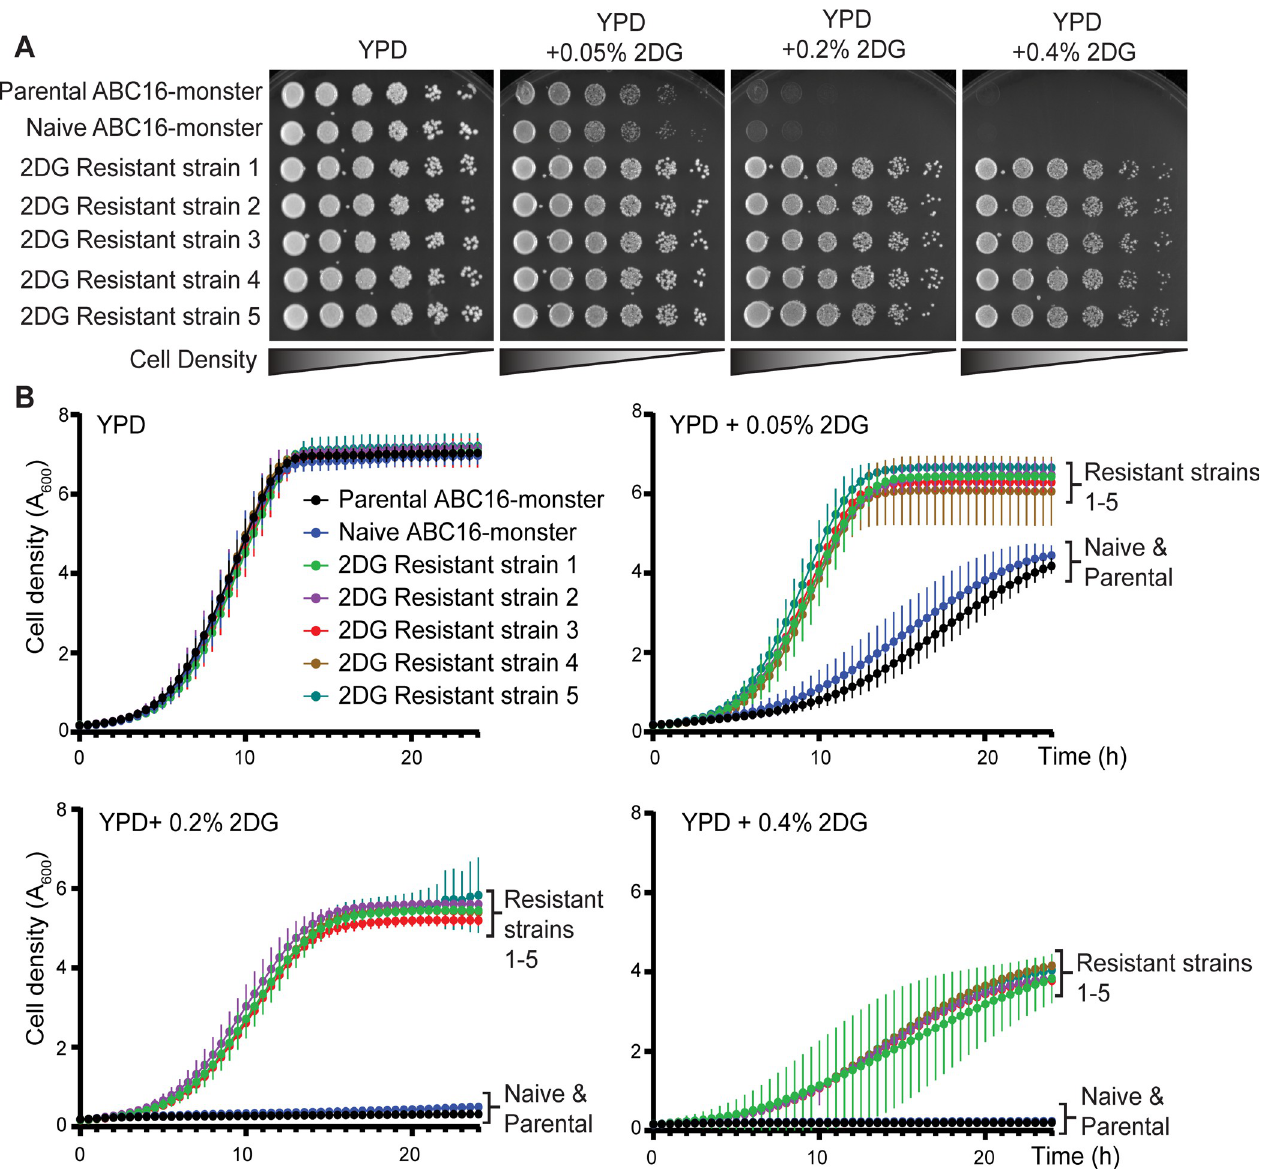
Fig 2. Cells from 2DG-resistant strains 1–5 are resistant to 2DG, but the parental control and na ï ve control cells are not. (A) Images of serial dilution growth assays on YPD (2% glucose as carbon source) or YPD with increasing concentrations of 2DG (0.05%, 0.2%, and 0.4%) after two days of growth at 30˚C. (B) Graphs showing the change in cell density over time for cells grown in YPD or YPD with increasing 2DG concentrations, each of which have 2% glucose as a carbon source. Data are plotted as the A 600 measured every 30 minutes during a 24-hour time course. Curves represent the average A 600 of three experimental replicates, and vertical lines emerging from each data point represent standard